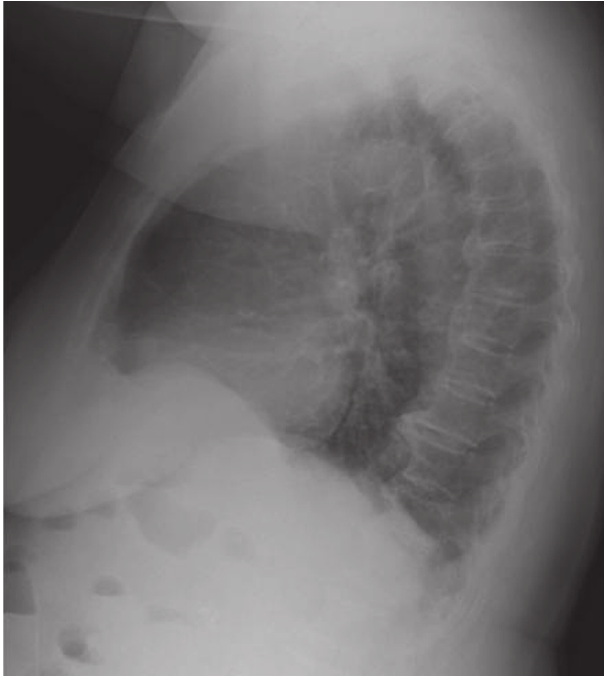
Figure 3 Profile chest X-ray showing diffuse calcification of the anterior longitudinal ligament with prominent formation of osteophytes in the thoracic spine.